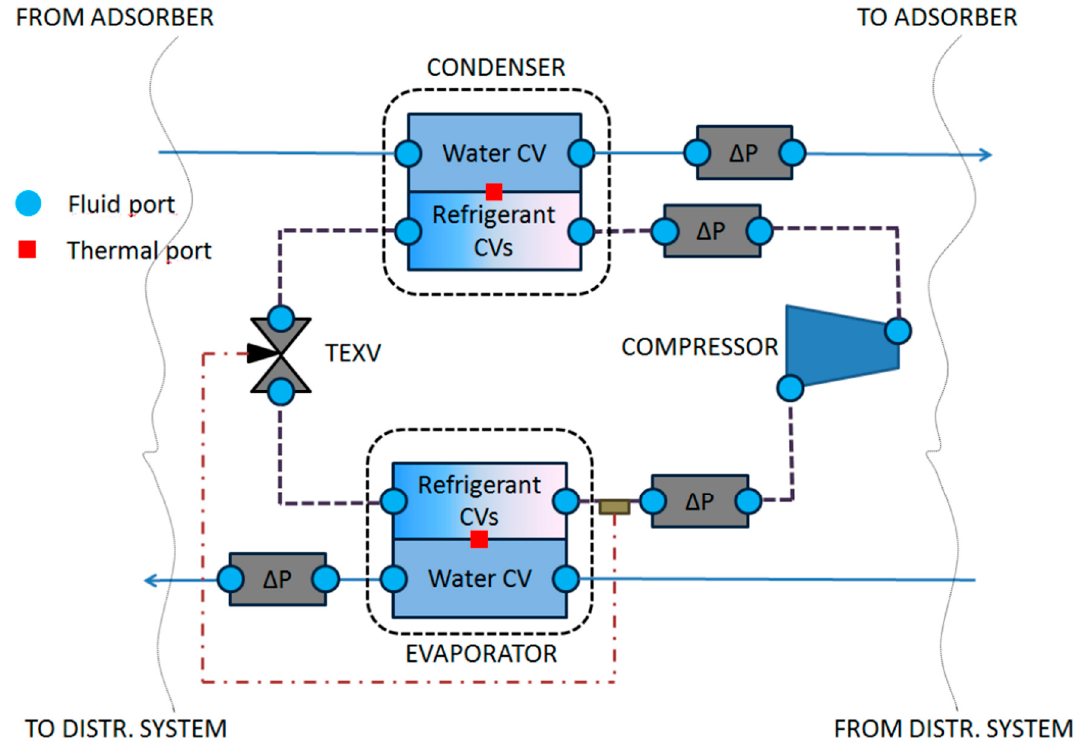
Figure 6. Compression chiller model layout representing the Dymola